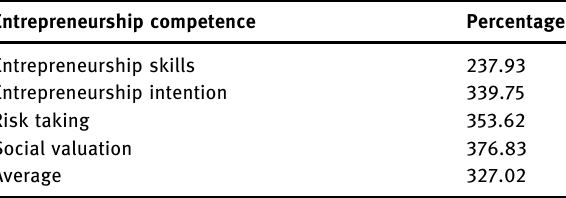
Table 9: Level of social valuation of poor farmers ( % )